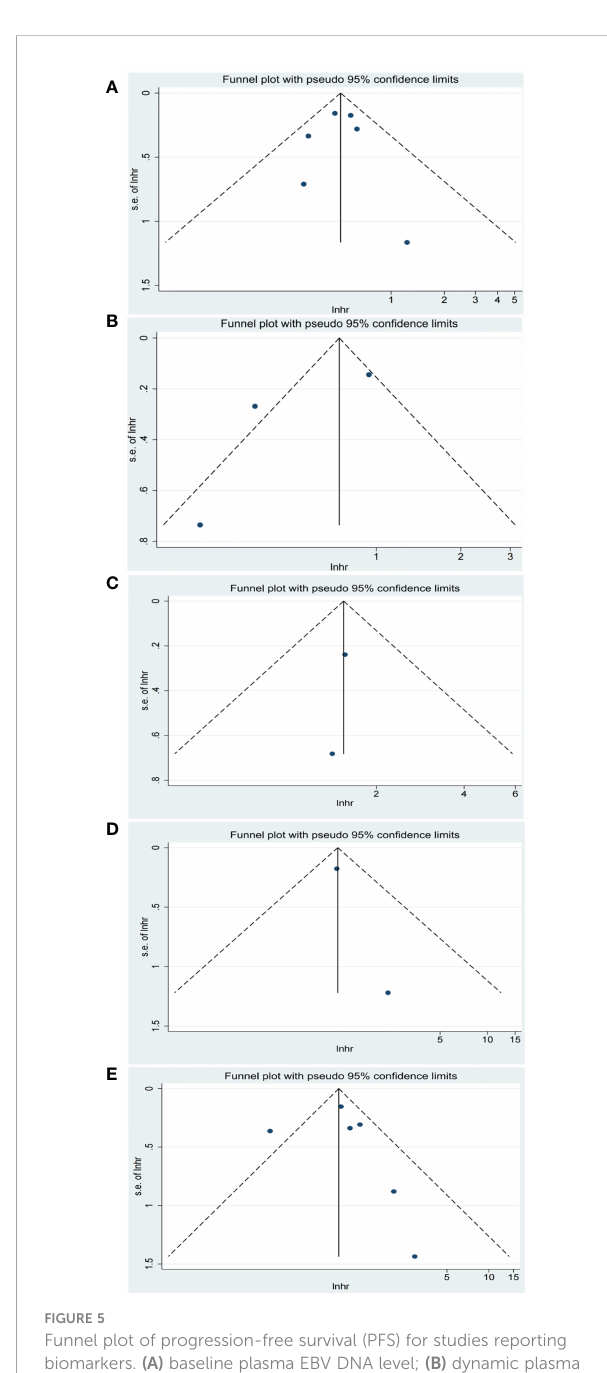
FIGURE 5 Funnel plot of progression-free survival (PFS) for studies reporting biomarkers. (A) baseline plasma EBV DNA level; (B) dynamic plasma EBV DNA load during immunotherapy; (C) programmed cell